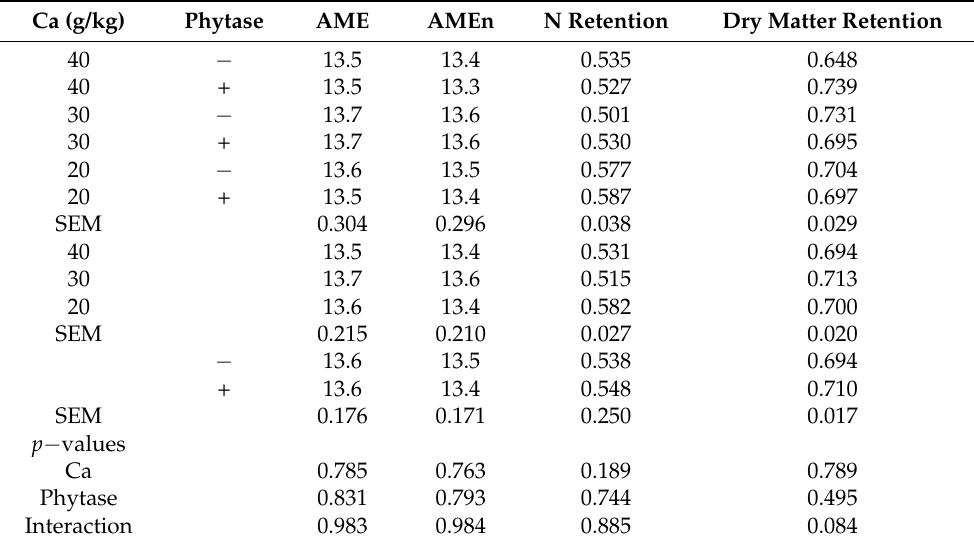
Table 6. Effect of dietary Ca concentrations and addition of phytase on measurements of digestibility and